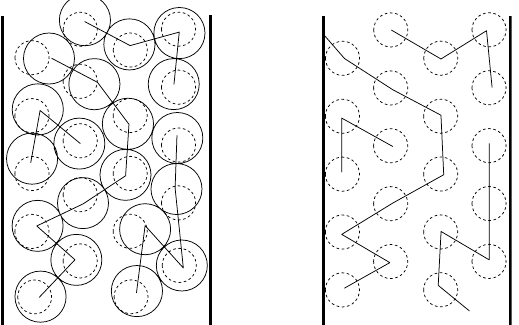
Figure 3. Schematic representation of ordered polymer structures in a confined geometry. Circles inside a solid line represent spherical monomers, polygonal lines represent polymer backbones. Monomers along a chain are strictly tangent (circles in solid line on left panel), monomers belonging to different chains do not need to, but can also be tangent. On both panels, circles with dashed lines represent sites of the perfect crystal. On average, polymer backbones can be considered self-avoiding random walks (SAWs) on the sites of the perfect crystal (right